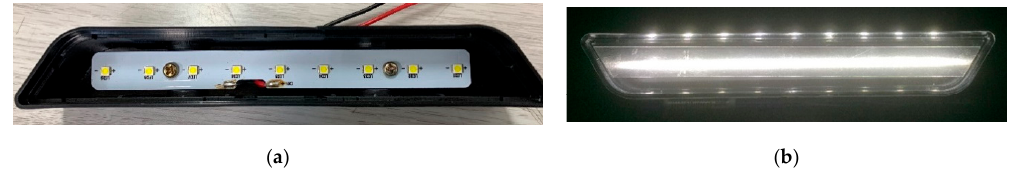
Figure 12. ( a ) The inner sight of the new optimized position lamp; ( b ) the outlook of the new optimized position lamp.